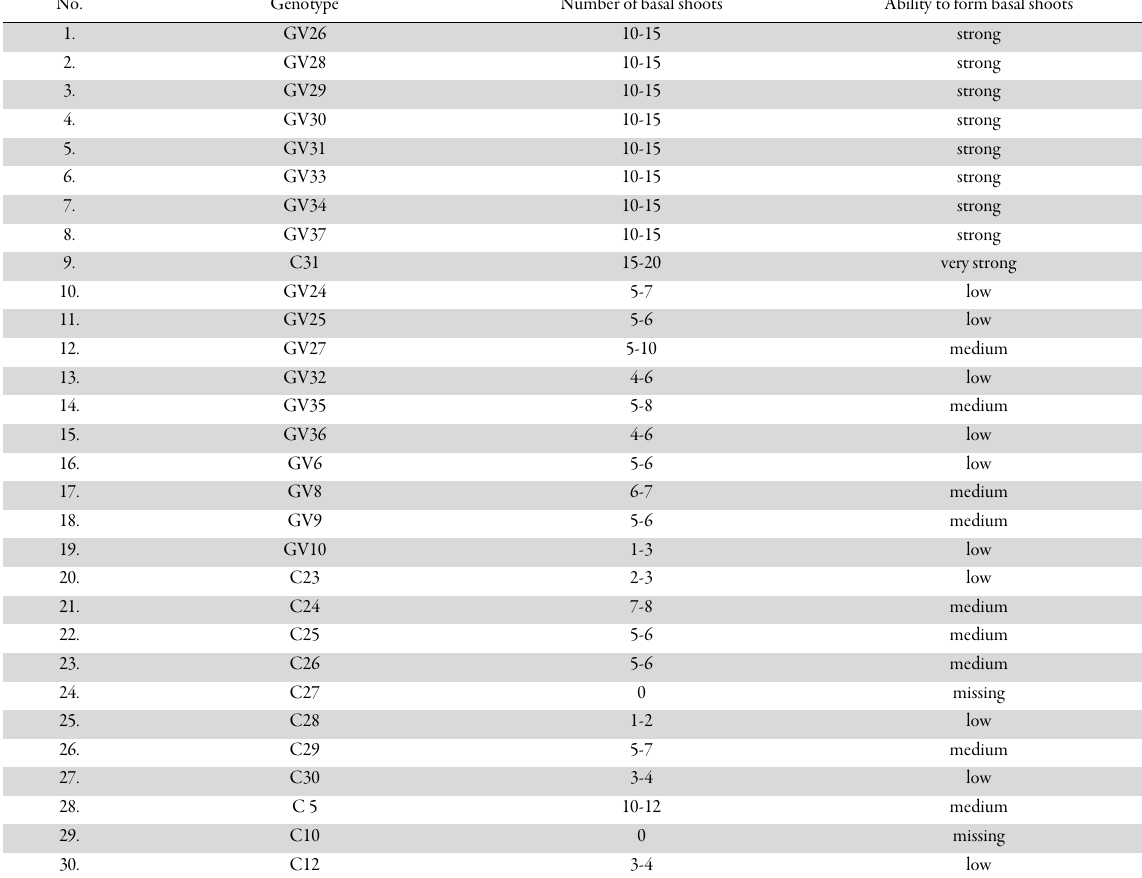
Table 4. Genotypes of Prunus spinosa L. selected in southern area of Oltenia for their ability to form basal shoots* No. Genotype Number of basal shoots